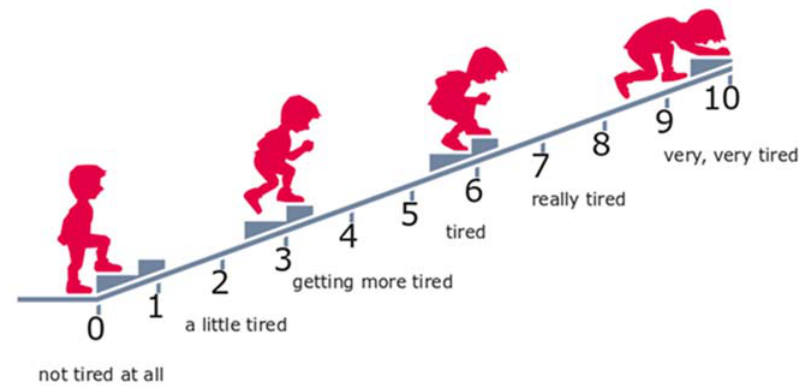
Figure 4. Children’s OMNI Scale of perceived exertion used in the experiment.